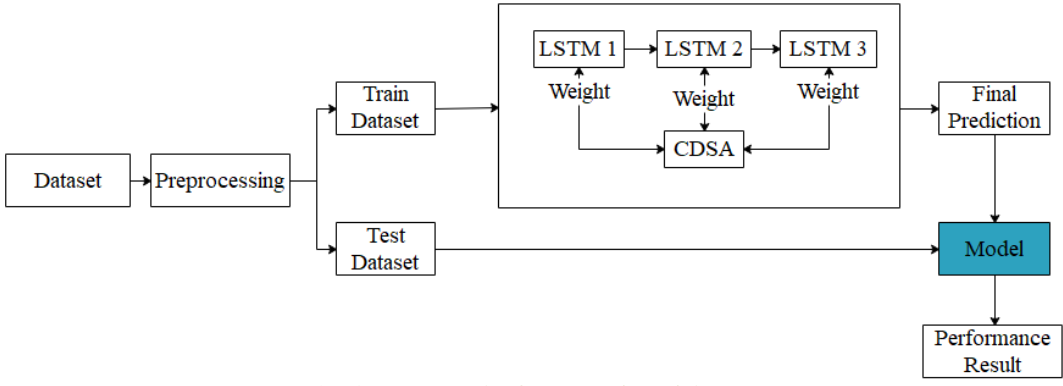
Fig. 4 . Framework of proposed